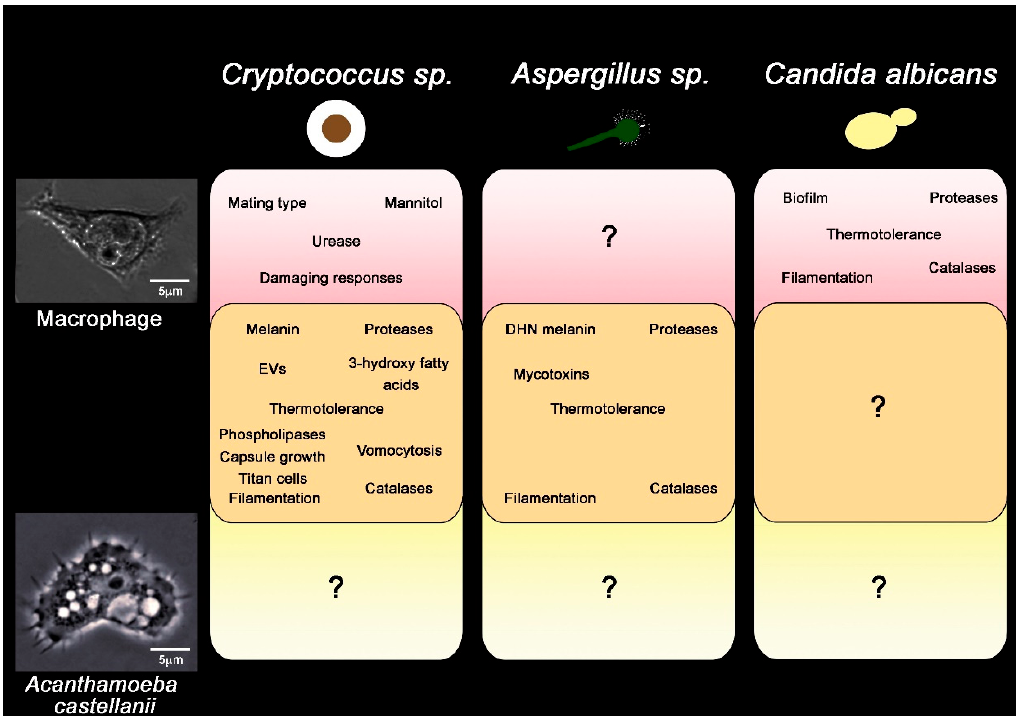
Figure 4. Summary of described virulence factors for three major fungal pathogens, in the context of their importance in the interaction with macrophage (pink), amoeba (yellow) or both (orange). For both Cryptococcus and Aspergillus spp. Several attributes have described that are important for both fungal cell survival in both amoeba and macrophages (orange box, center). For C. albicans comparable studies in amoeba have not been undertaken. Question marks denote uncertainty about traits specific to either macrophages or amoeba.